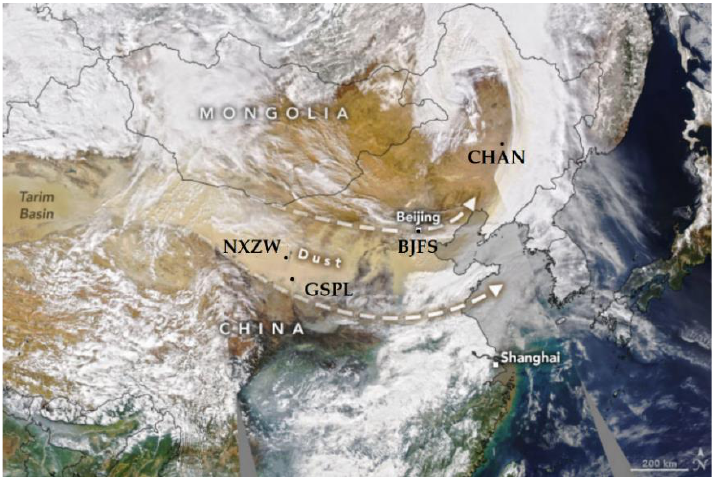
Figure 1. Trends of sandstorms in northern China on 15 March 2021 provided by NASA [11].